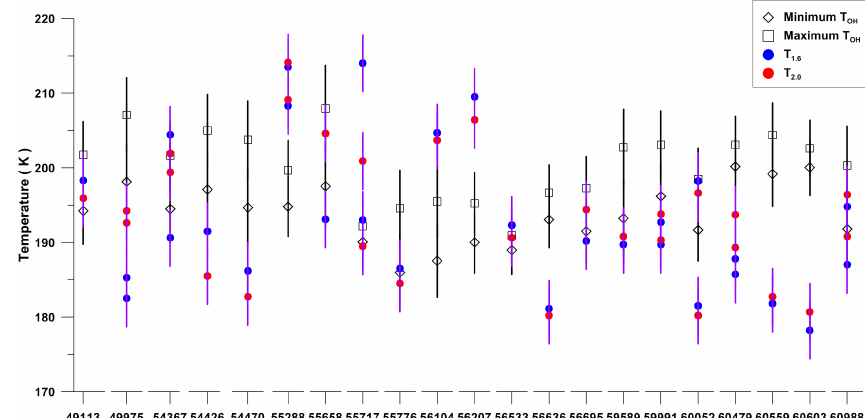
Figure 8. Plots showing limits of T OH variation in a 3 ◦ × 3 ◦ latitude–longitude grid over Ranchi for coincidental events and comparison with T 1 . 6 and T 2 . 0 measurements.